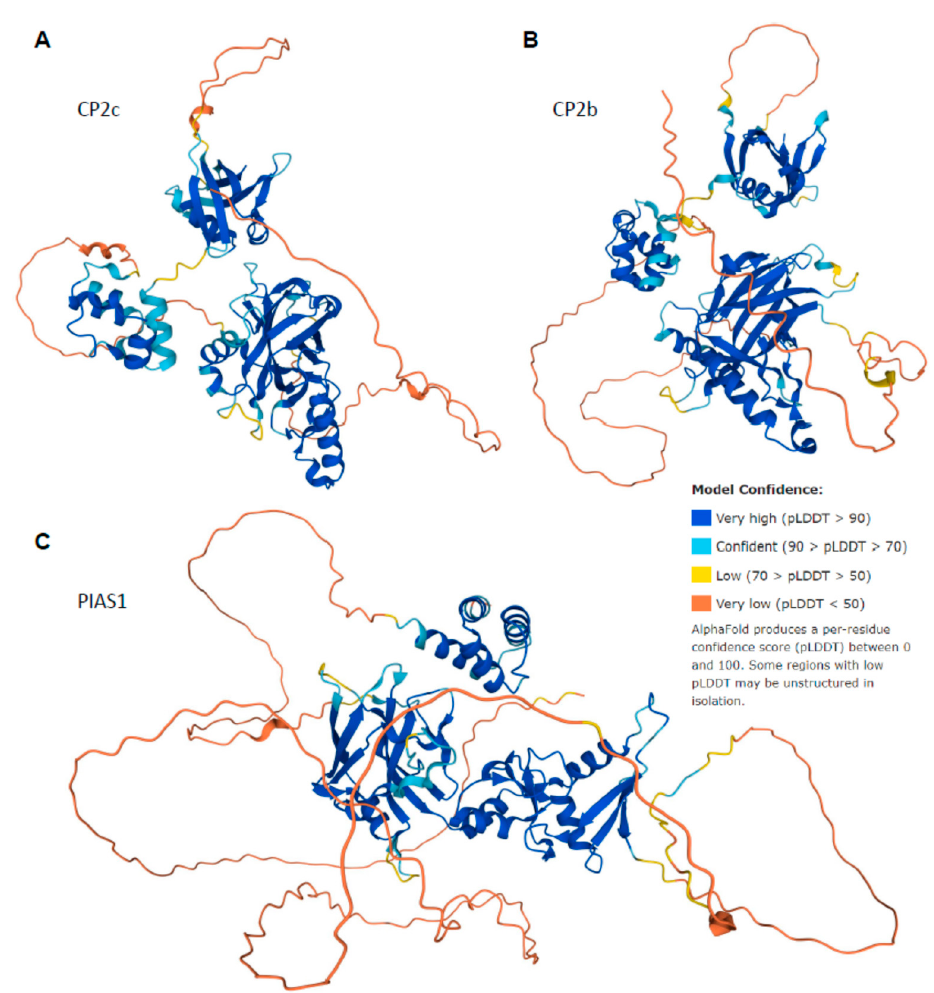
Figure 10. 3D structures of CP2c ( A ), CP2b ( B ), and Pias1 ( C ) modeled by AlphaFold. Note that in addition to globular domains (shown by blue and cyan colors) these proteins contain long regions, whose structures are predicted with low or very low confidence (yellow and orange segments), which might be unstructured in isolation.